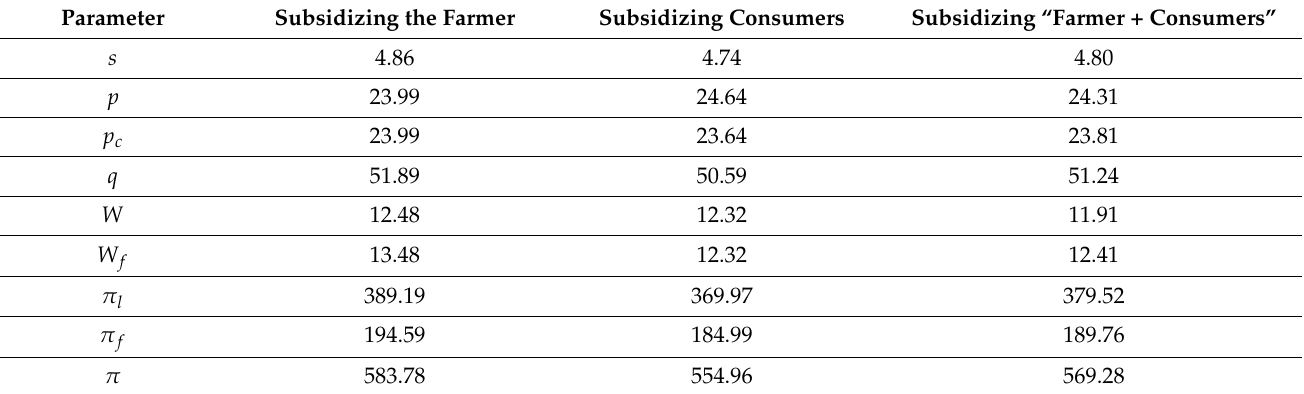
Table 8. Comparison of optimal decision-making and profit levels between government-subsidized the farmer, consumers, and “farmers +